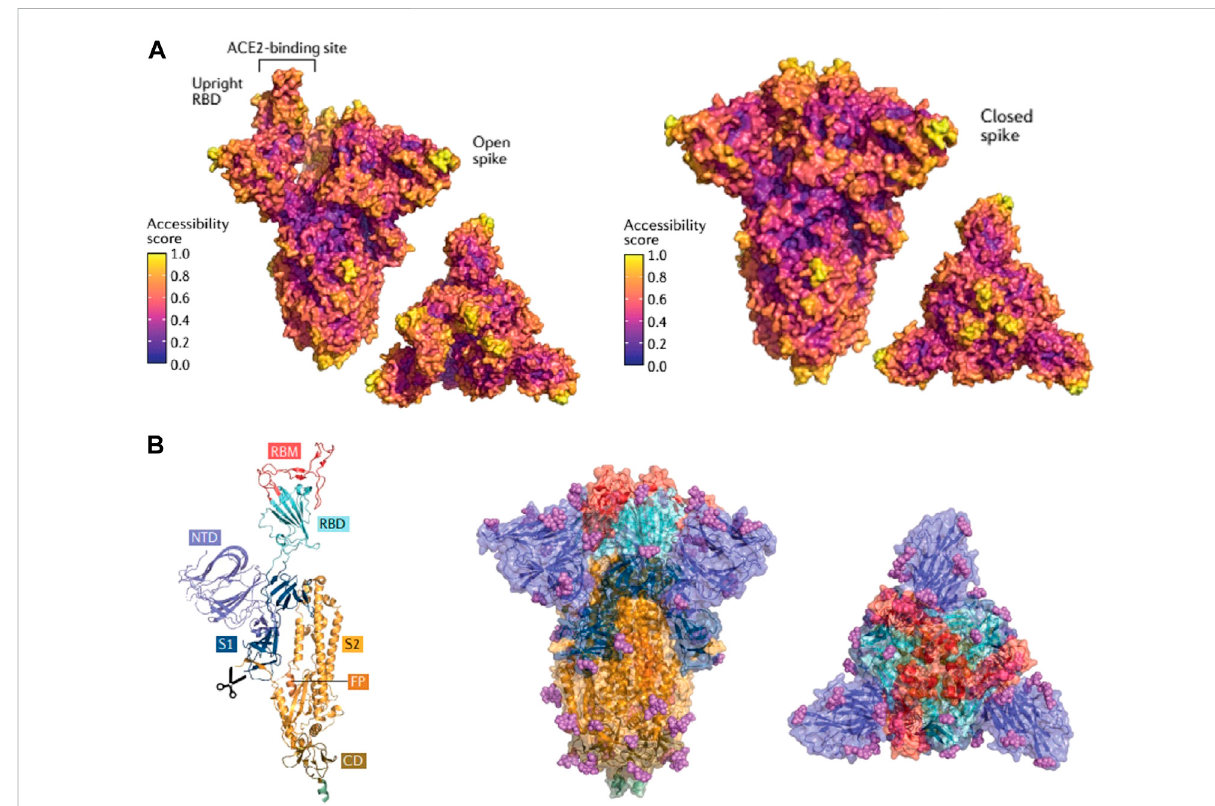
FIGURE 3 SARS-CoV-2 Spike protein structures illustrating regions speci fi c for antibody binding and domains prone to speci fi c amino acid mutations responsible for emerging variants of concern synthesized by researchers (Harvey et al., 2021). (A) . SARS-CoV-2 Spike protein in an open conformation and closed conformation exhibiting key areas of antibody binding based on conformational epitopes. Colors are based on antibody accessibility scores where high values on the scale indicate higher antibody recognition. Lower values of antibody accessibility indicate a lower antibody recognition which strongly correlates to domains containing amino acid mutations characteristic of emerging variants of concern. (B) . SARS-CoV-2SpikeProteincomposition:RBM(receptorbindingmotif),RBD(receptorbindingdomain),NTD(amino-terminaldomain),S1(subunit1, part of NTD and RBD responsible for binding ACE2), S2 (Subunit 2, part of trimeric protein core responsible for membrane fusion). This fi gure is reprinted with permission from Nature Springer from (Harvey et al.,